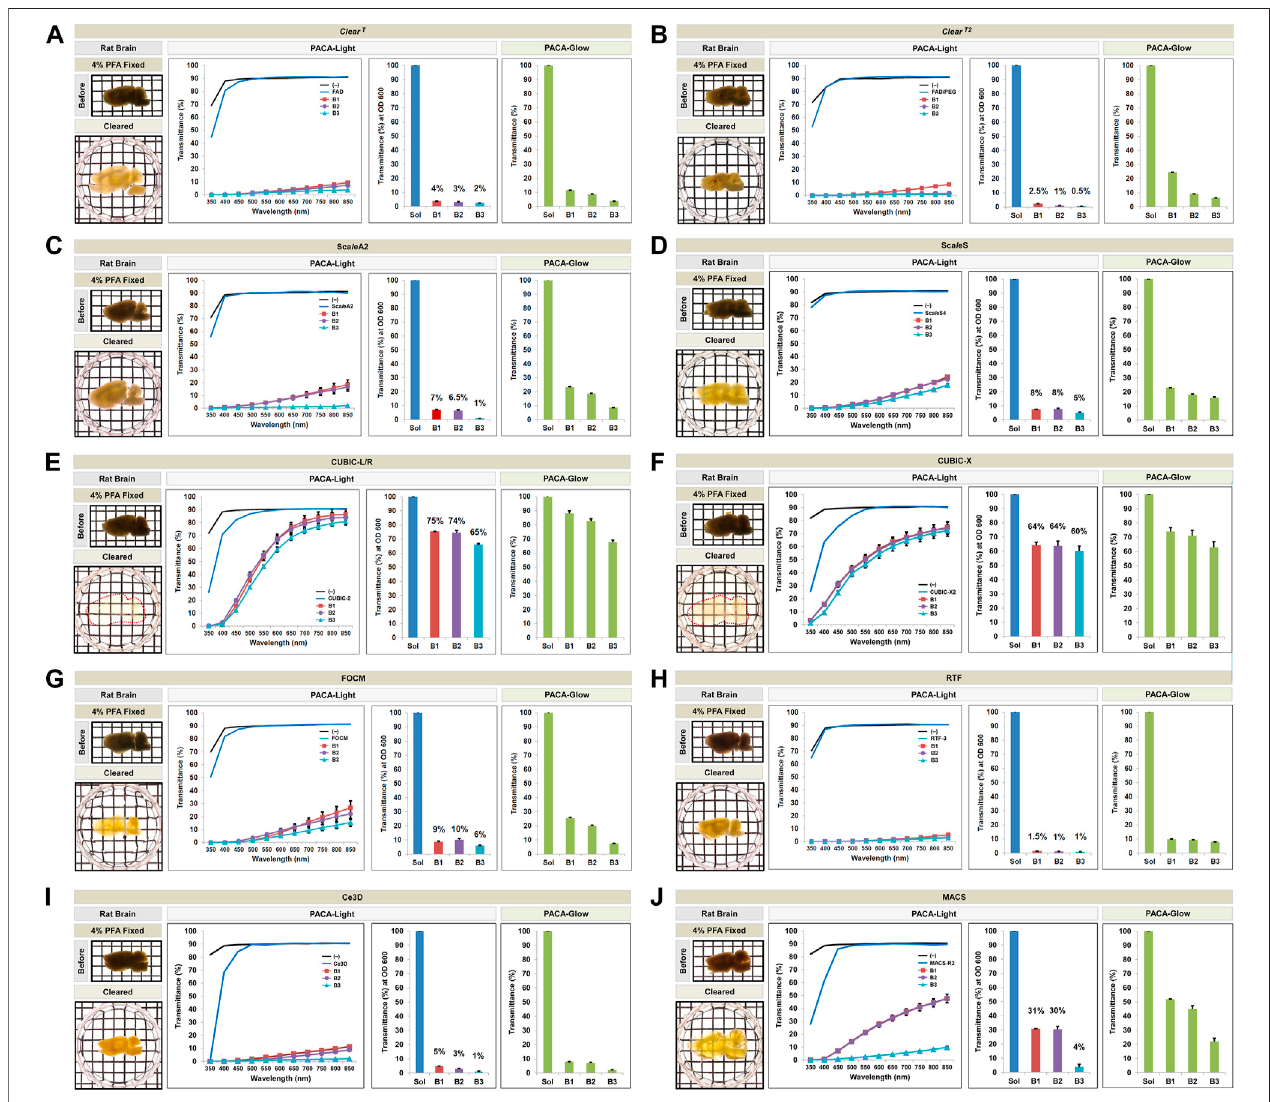
FIGURE 4 | Comparison of tissue clearing achieved with ten hydrophilic tissue clearing methods. Comparison of clearing ef fi cacies of Clear T (A) , Clear T2 (B) , Sca l eA2 (C) , Sca l eS (D) , CUBIC-L/R (E) , CUBIC-X (F) , FOCM (G) , RTF (H) , Ce3D (I) , and MACS (J) on rat brain samples (3 mm thickness) with both PACA-Light and PACA-Glow. All tissue clearing time course are shown in Supplementary Figures S6, S7 . Optical images showing samples after clearing (red dotted line), along with any changes in sample size upon tissue processing, are included (also Supplementary Figure S12 ). Three discs from three distinct brain regions (B1: prefrontal cortexandbasalganglia,B2:cerebralcortexandmidbrain/diencephalon,B3:cerebellum)weregeneratedandanalyzedforeachsample.Eachcolorlineandbarpointto assessment values of empty (black) and refractive index matching solution (blue) of each protocol, and three distinct regions of the brain the B1 (square, red), B2 (diamond, violet), and B3 (triangle, sky blue). Green bars point to assessment values of the glow light (unit) in the dark. Results represent three replicates of each experiment, and data are presented as the mean ± SD (standard deviation). The transparency of the cleared brain was evident against a patterned background (length: width (cid:1) 5 mm:5 mm).